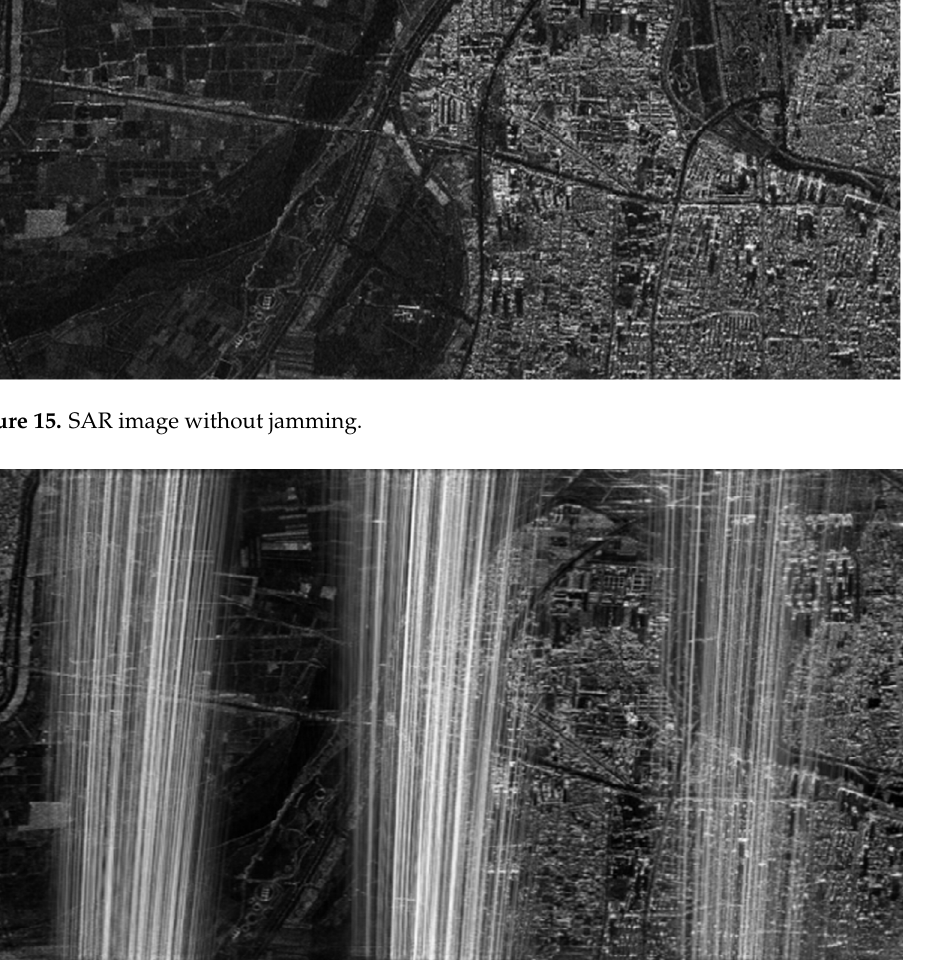
Figure 16. SAR image with jamming.